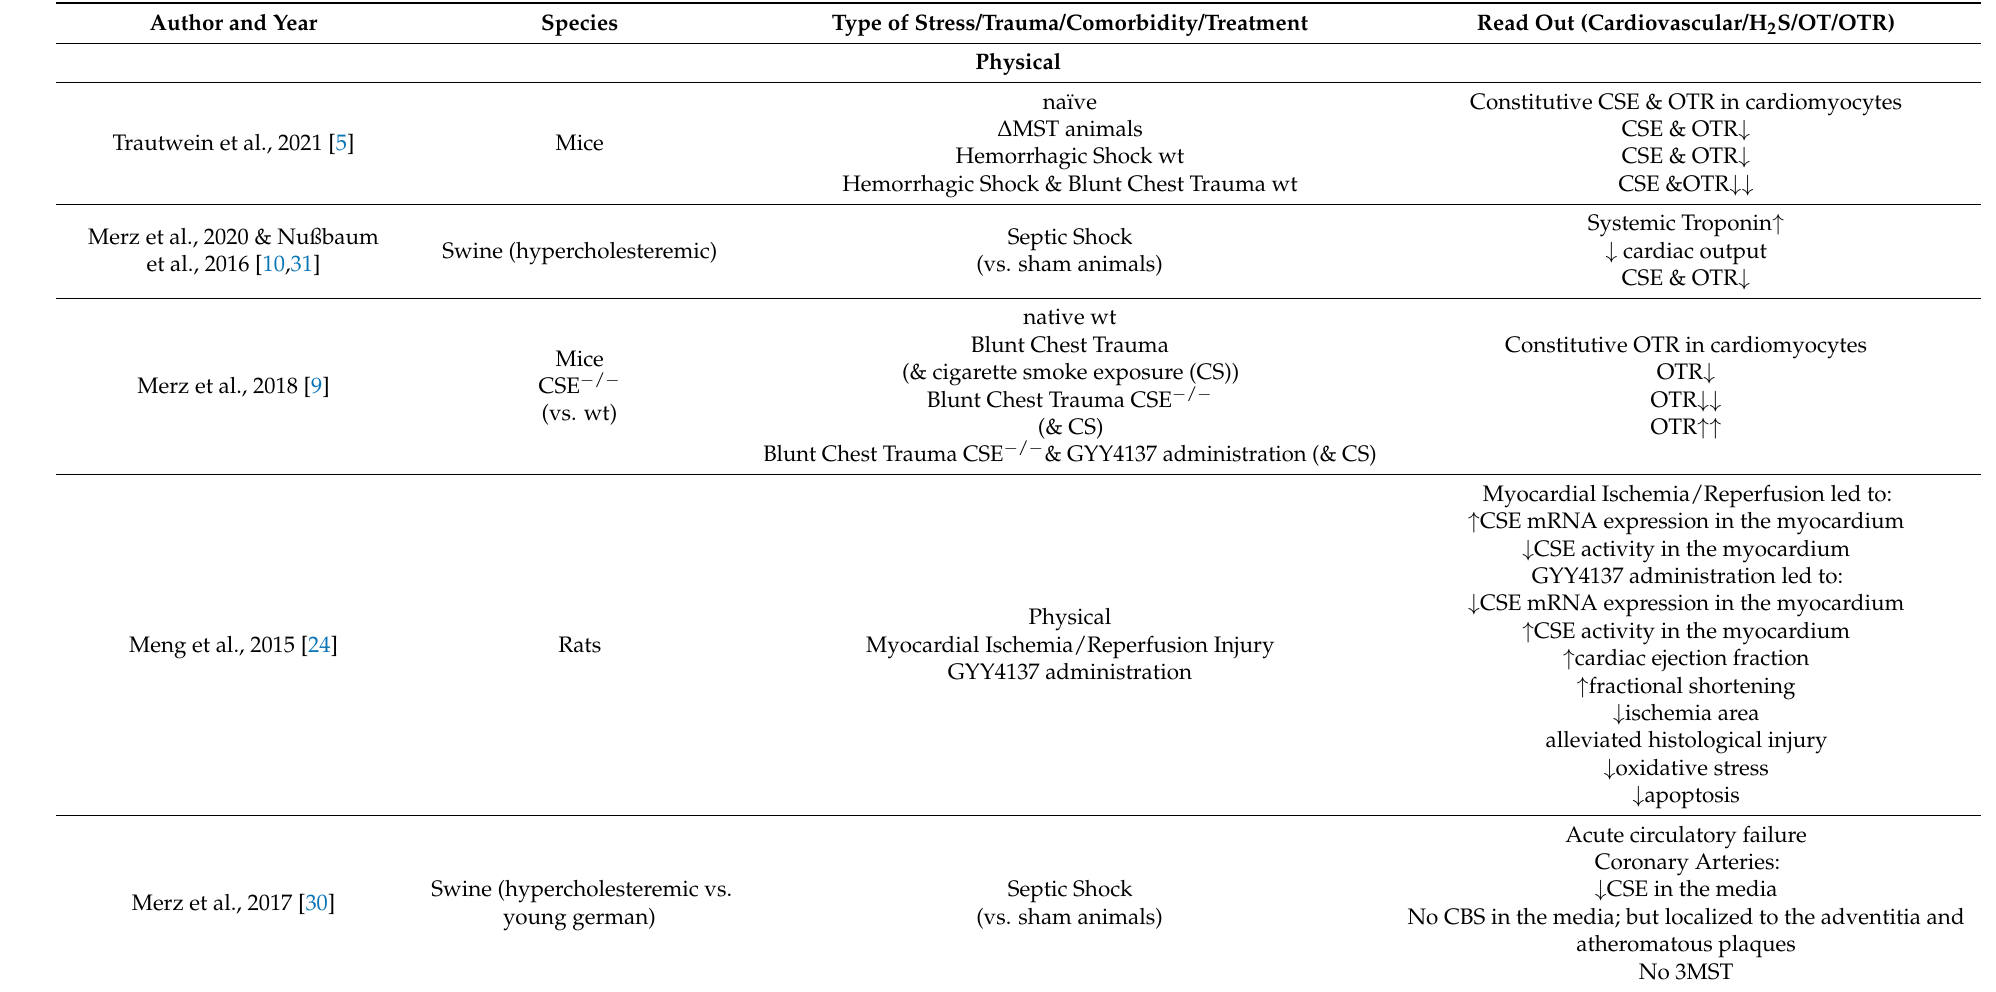
Table 1. Summary of animal studies: effects of stress/trauma/comorbidity and treatment on the cardiovascular system, H 2 S system and the OT/OTR